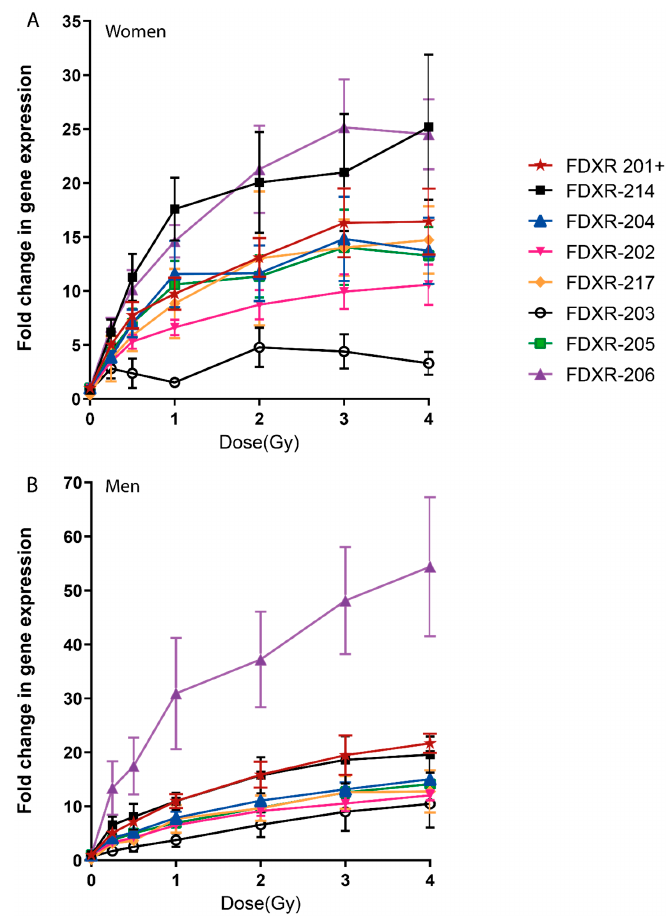
Figure 2. Comparison of gene expression FDXR variants in human blood irradiated ex vivo in women ( A ) and men ( B ). Blood from five women and five men was exposed to a range of X-ray doses (0.25, 0.5, 1, 2, 3, 4 Gy; dose rate 0.5 Gy/min) and incubated for 24 h at 37 °C. The data are presented as mean values ± standard error of the mean (SEM). Statistical analyses were performed in log-transformed data. One-way ANOVA followed by Tukey’s test was performed for statistical